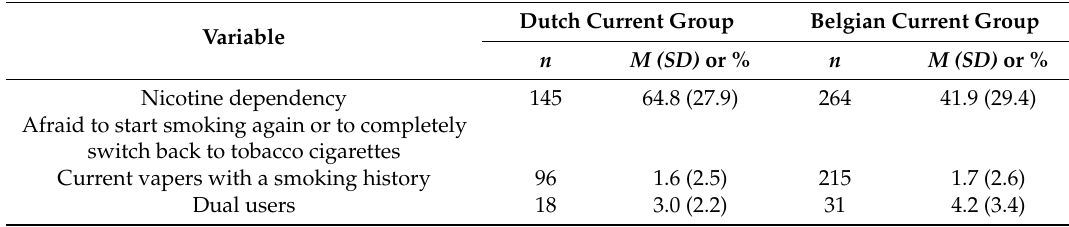
Table 7. Nicotine dependency and fear to start smoking again for the Dutch Current/Belgian Current group. Variable